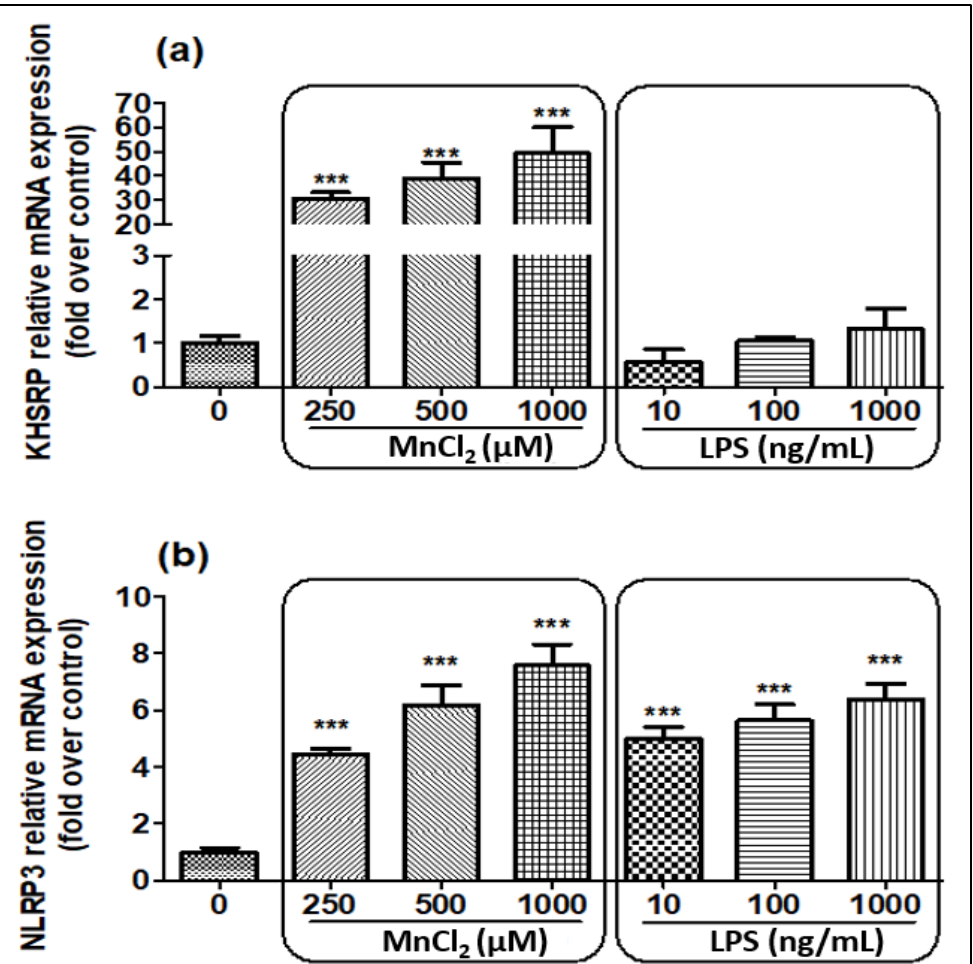
Figure 2. Effect of MnCl 2 and LPS on mRNA expression of KHSRP and NLRP3 detected by qPCR post-24 h of exposure. ( a ) Relative mRNA expression levels for KHSRP; ( b ) Relative mRNA expression levels for NLRP3. All mRNA values were normalized to the housekeeping mRNA, GAPDH, and expressed as a fold-induction over the control sample (set at a value of 1). Data represented as mean ± SEM. *** p < 0.0001 vs. control group.